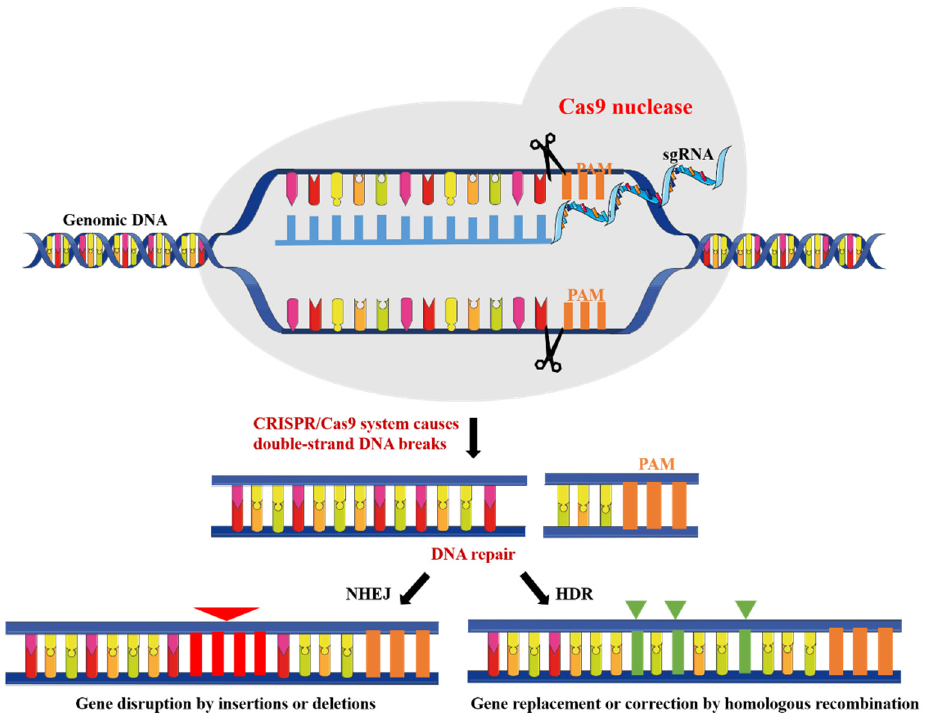
Figure 1. The composition and function of CRISPR/Cas9 system: the Cas9 nuclease is directed to the target DNA by complementary base-pairing with its bound sgRNA. The target site must be followed by a 3 ′ PAM sequence. The following cleavage of double-strand DNA triggers either the error prone non-homologous end joining (NHEJ) or homology directed repair (HDR) mechanisms.